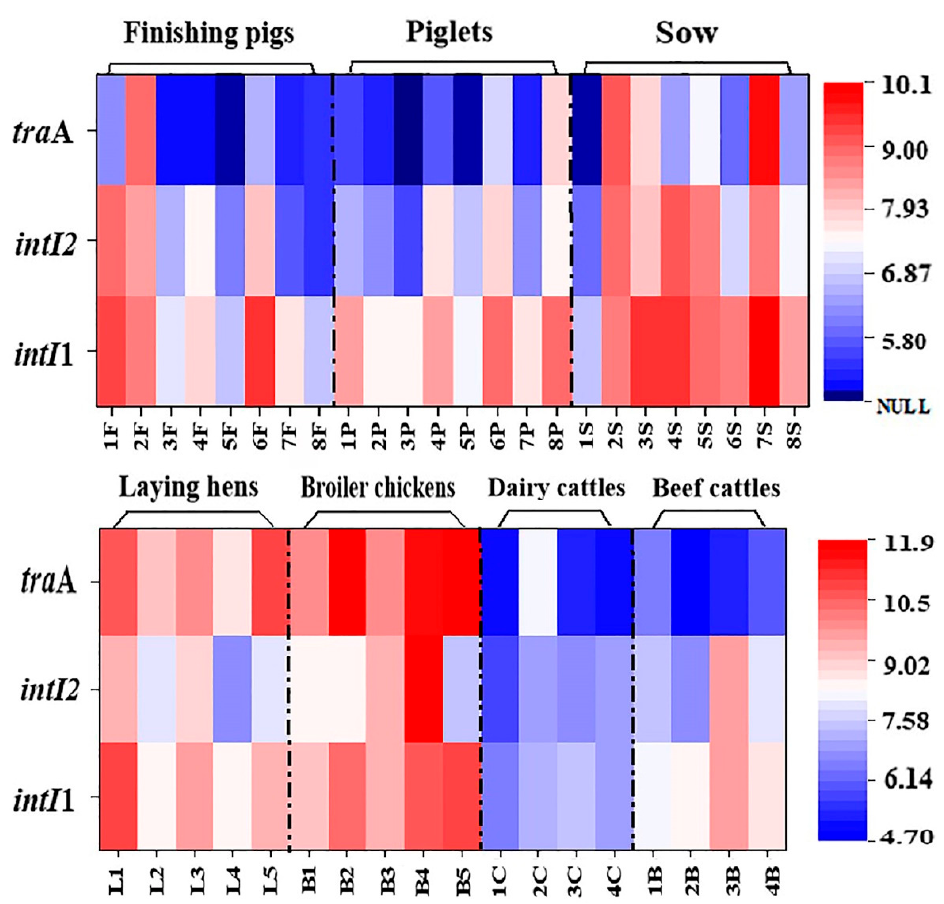
Figure 5. The concentration of MGEs in livestock manure from family farms.